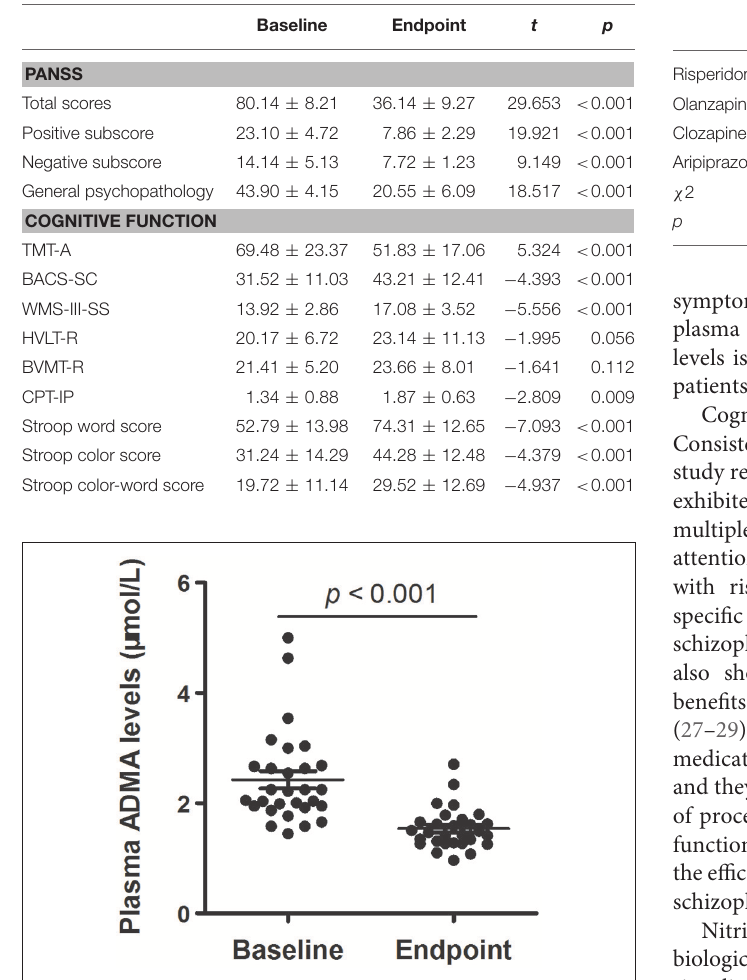
p = 0.026) or CPT subscore ( r = − 0.417, p = 0.025), indicating